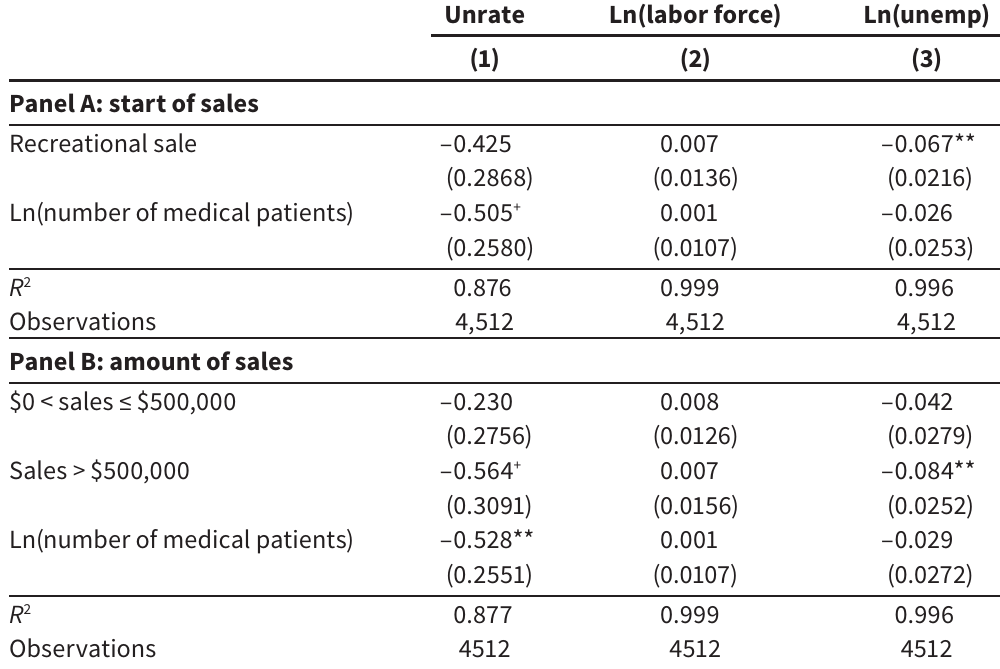
The effect of recreational dispensary entry and sales on the